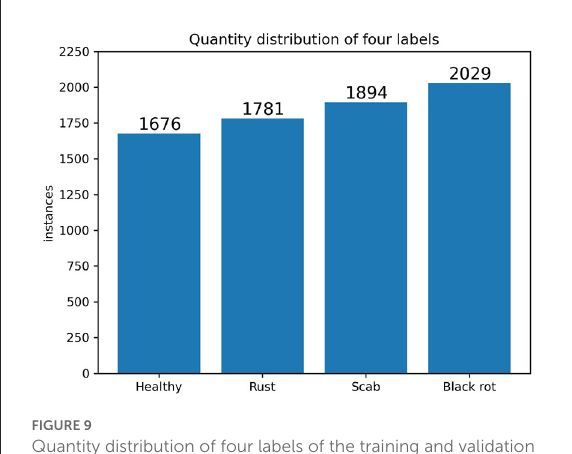
FIGURE9 Quantity distribution of four labels of the training and validation datasets. The numbers of healthy, rust, scab, and black rot labels are 1,676, 1,781, 1,894, and 2,029, respectively. The total number of images is 6,802 and the total number of labeled leaves is 7,380, which means that there are 7,380 leaf objects for training and validation.